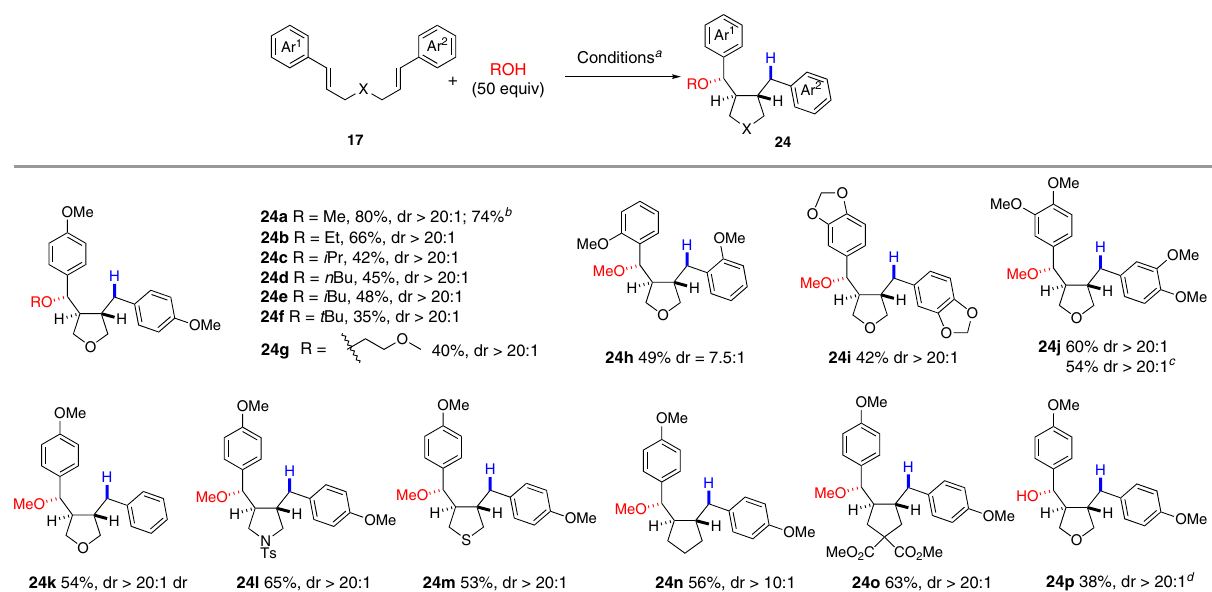
Fig. 7 Synthesis of C7-monoalkoxy dibenzyl tetrahydrofuran. Reagents and conditions: (a) 17 (0.1 mmol), [Mes-Acr-Me] + BF 4 − (5 mol%), PhSSPh (20 mol%), alcohol (5.0 mmol), DCM (1.0 mL), 24 W blue LED, 23 °C, 36 – 48 h; (b) 2.5 g scale; (c) 1.0 g scale; (d) THF:H 2 O (v/v = 1:1, 1 mL) was used as solvent. Yields refer to isolated pure